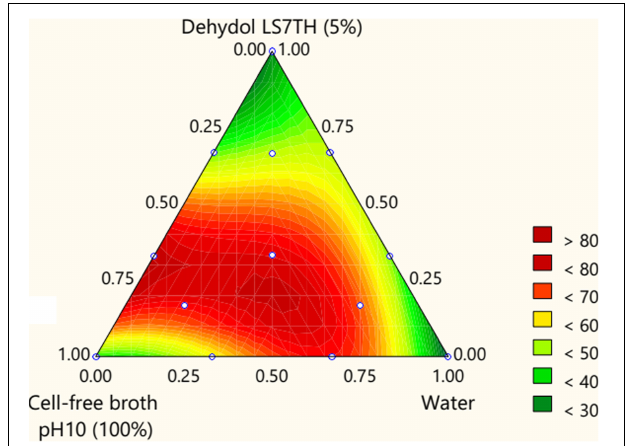
FIGURE 4 | Contour response surface plot for optimizing the components of F1 formulation. Lipopeptide solution was used as cell-free-broth (pH = 10). The initial concentration of Dehydol LS7TH was 5% (v/v). The ratio of cutting (g) to washing agent (mL) was